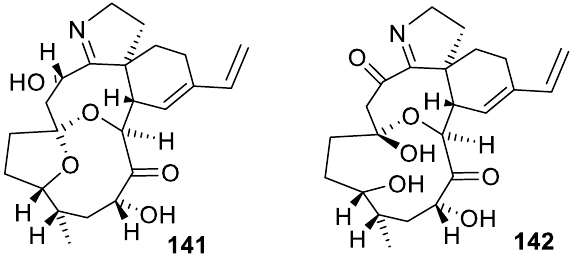
Figure 67. Portimines A and B isolated from Vulcanodinium rugosum containing both one [4.7.0] and one [4.5.0] spirocyclic motif.